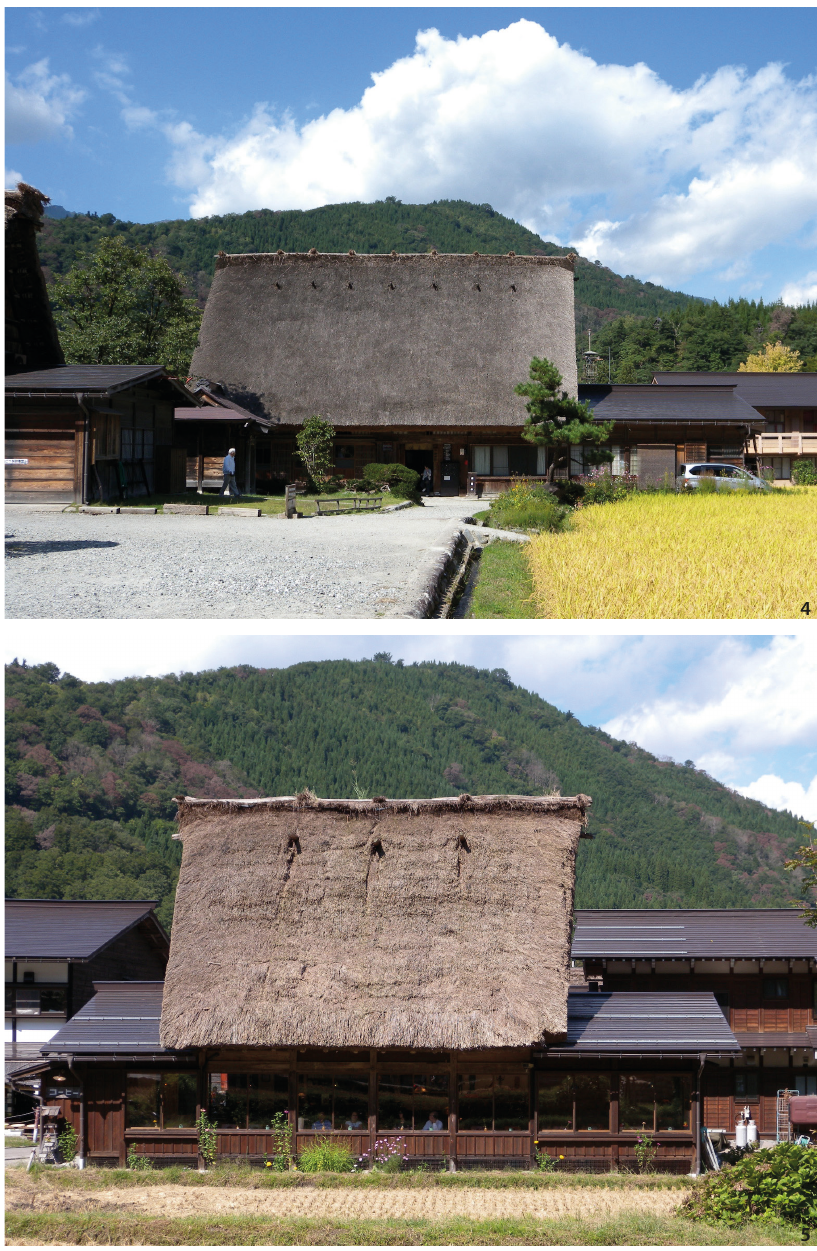
Figure 4 Gassho-style house with extension (Source: the author). Figure 5 Gassho-style house with extension on both sides (Source: the